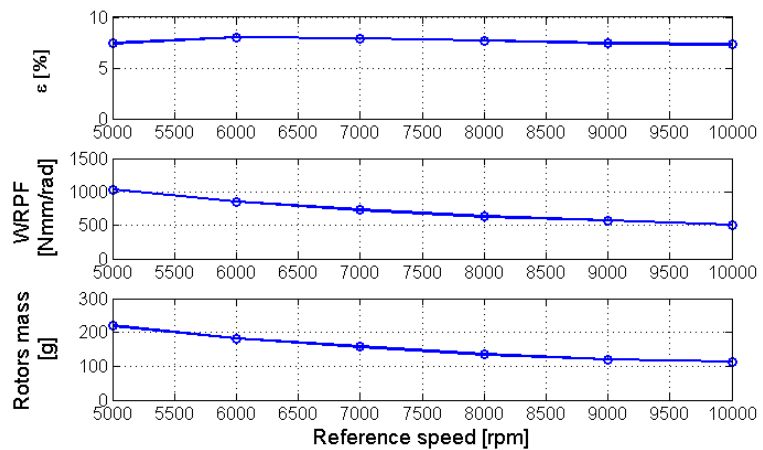
Figure 13. Cycloidal profile—single objective optimization results.